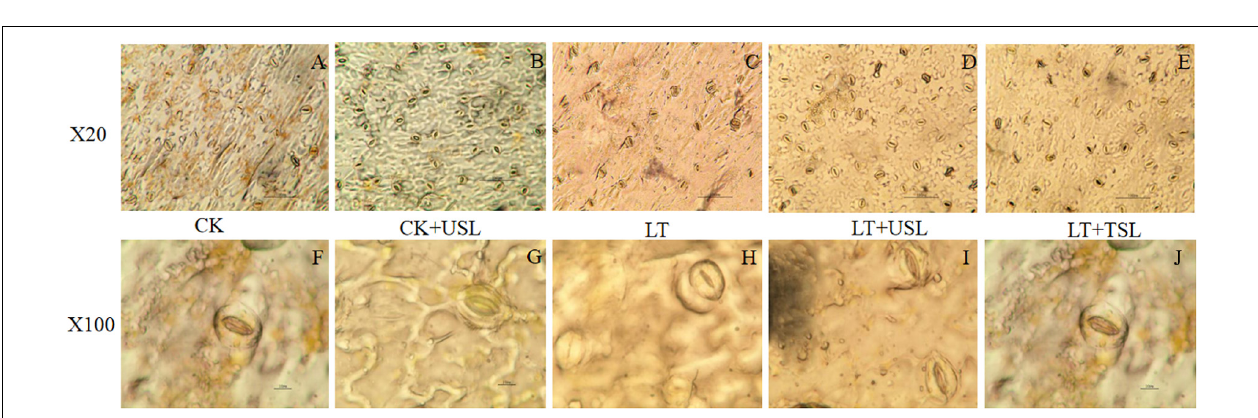
FIGURE 5 | Effects of USL on the energy fluxes between photosystems in tomato leaves under LT stress. (A) Y(NO), the quantum yield of non-regulated energy dissipation; (B) Y(NPQ), the quantum yield of regulated energy dissipation; (C) Y(ND), PS I donor side limitation; and (D) Y(NA), PS I acceptor side limitation.